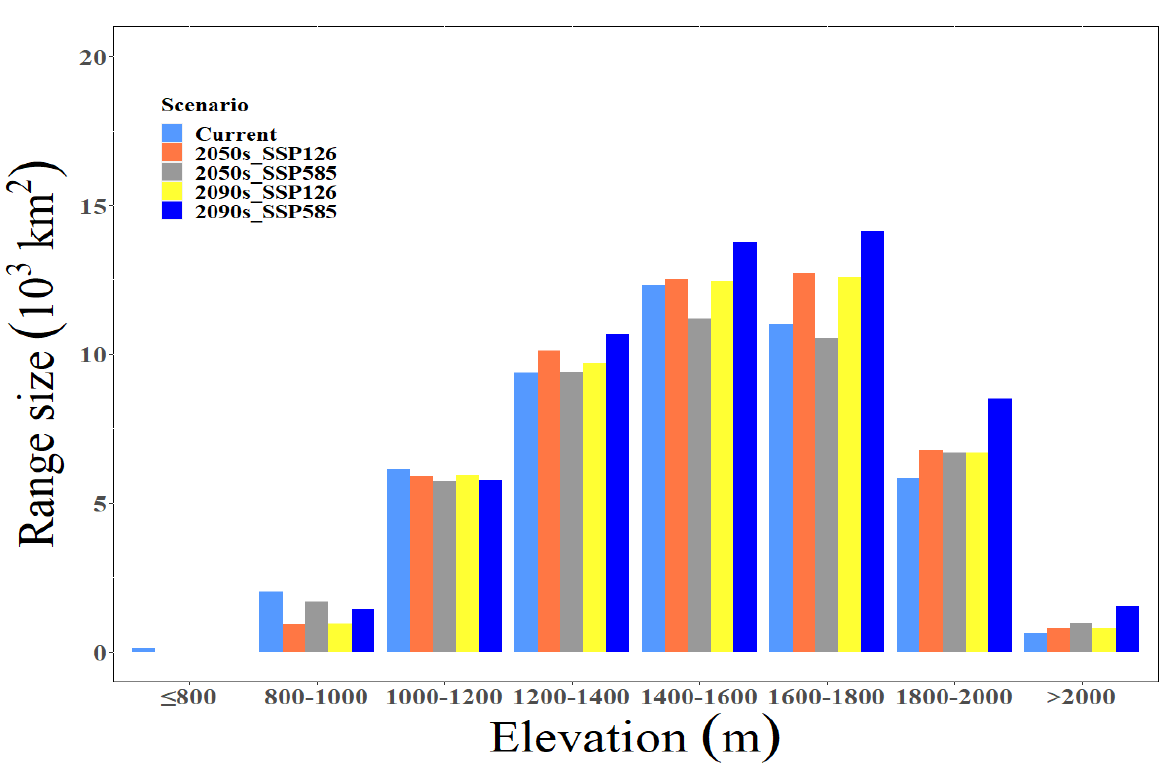
Figure 4. The changes in range size for wild apple along elevations under the current and future